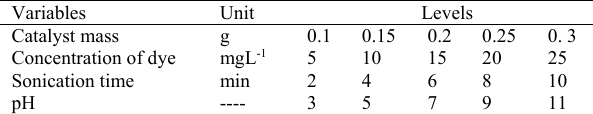
Table 2. Experimental range and levels of independent process variables.